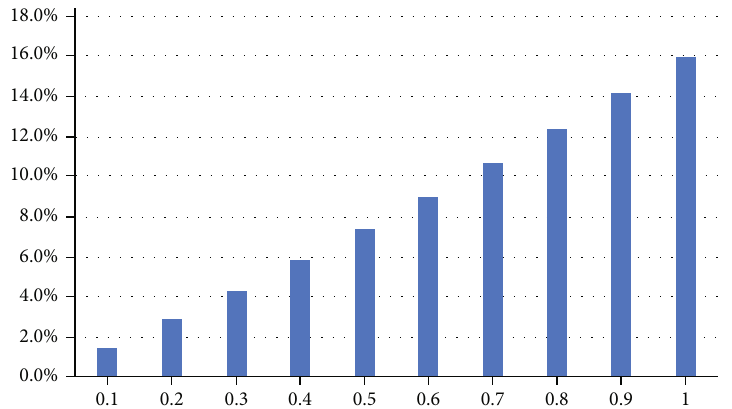
Figure 7: Market share of small producers as a function of the state subsidy with a reduction in